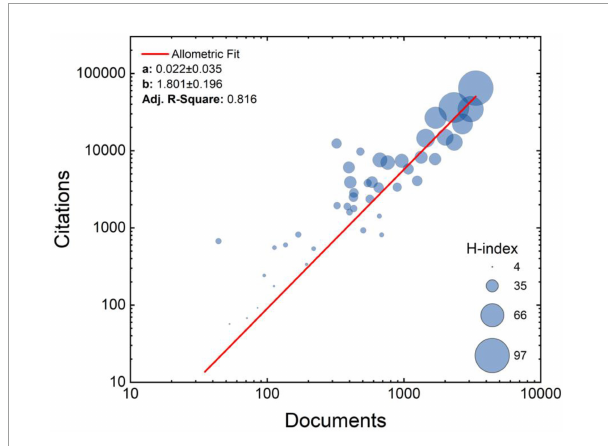
FIGURE4 Correlation between the total number of documents, citations, and H-Index of Ecuadorian Universities.